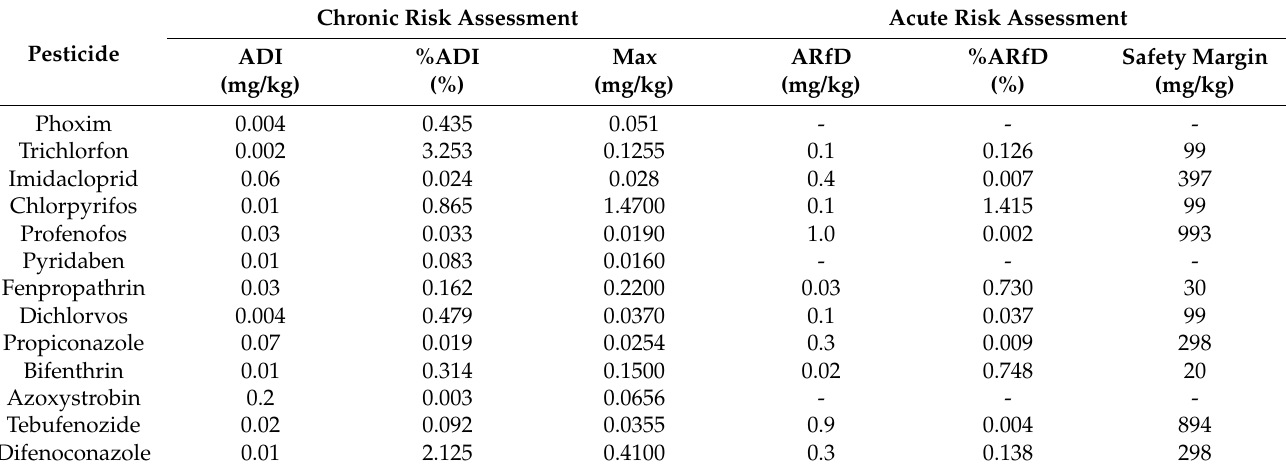
Table 7. The risk assessment of pesticide residues.